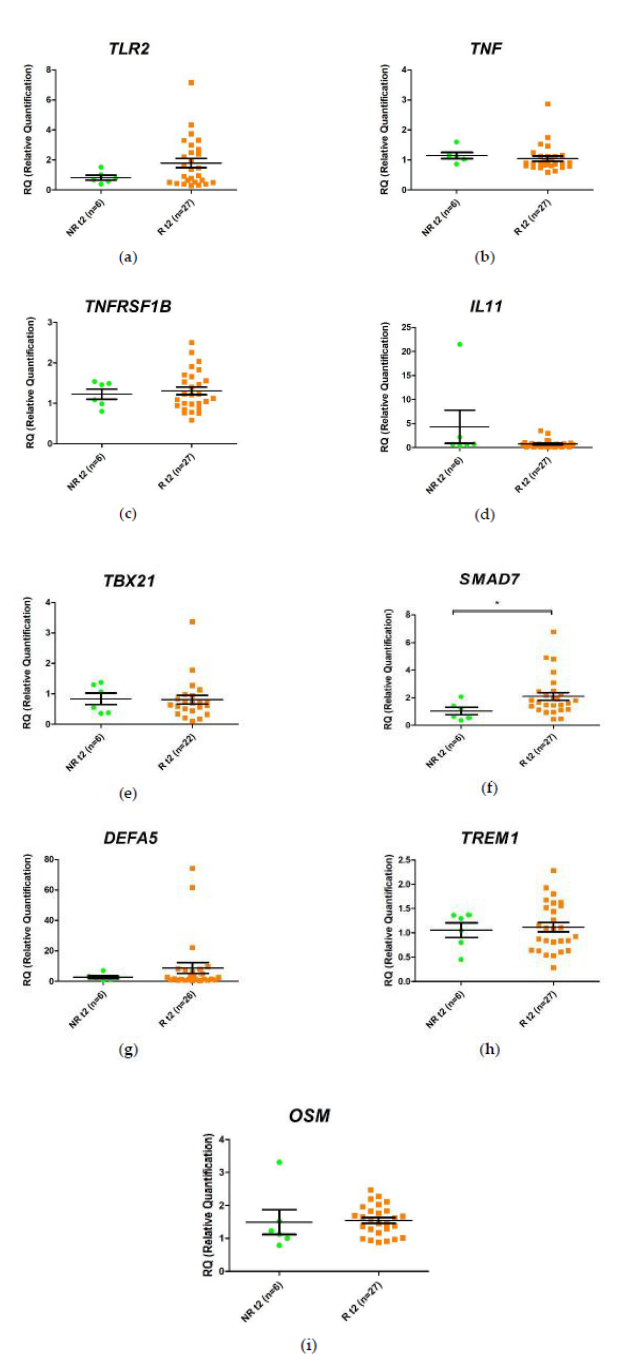
Figure 3. Relative expression levels of the ( a ) TLR2, ( b ) TNF, ( c ) TNFRSF1B, ( d ) IL11, ( e ) TBX21, ( f ) SMAD7, ( g ) DEFA5, ( h ) TREM1, and ( i ) OSM genes in responders (R) and non-responders (NR) at 2 weeks after anti-TNF administration. Expression values were normalized to HPRT1 and GAPDH genes. Values are expressed as mean (horizontal line), standard error of the mean (SEM). n , sample size. * p value < 0.05 vs. control (unpaired t